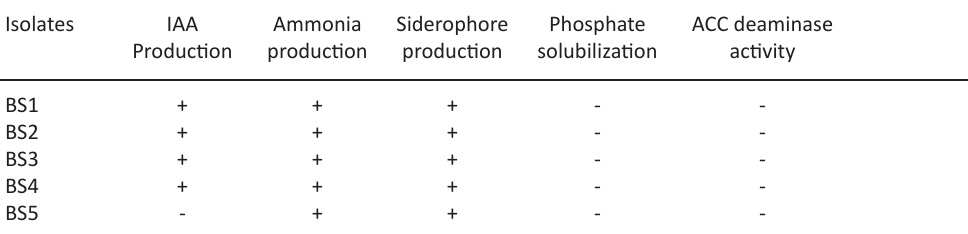
Table 3. BLAST analysis and sequence submission Source